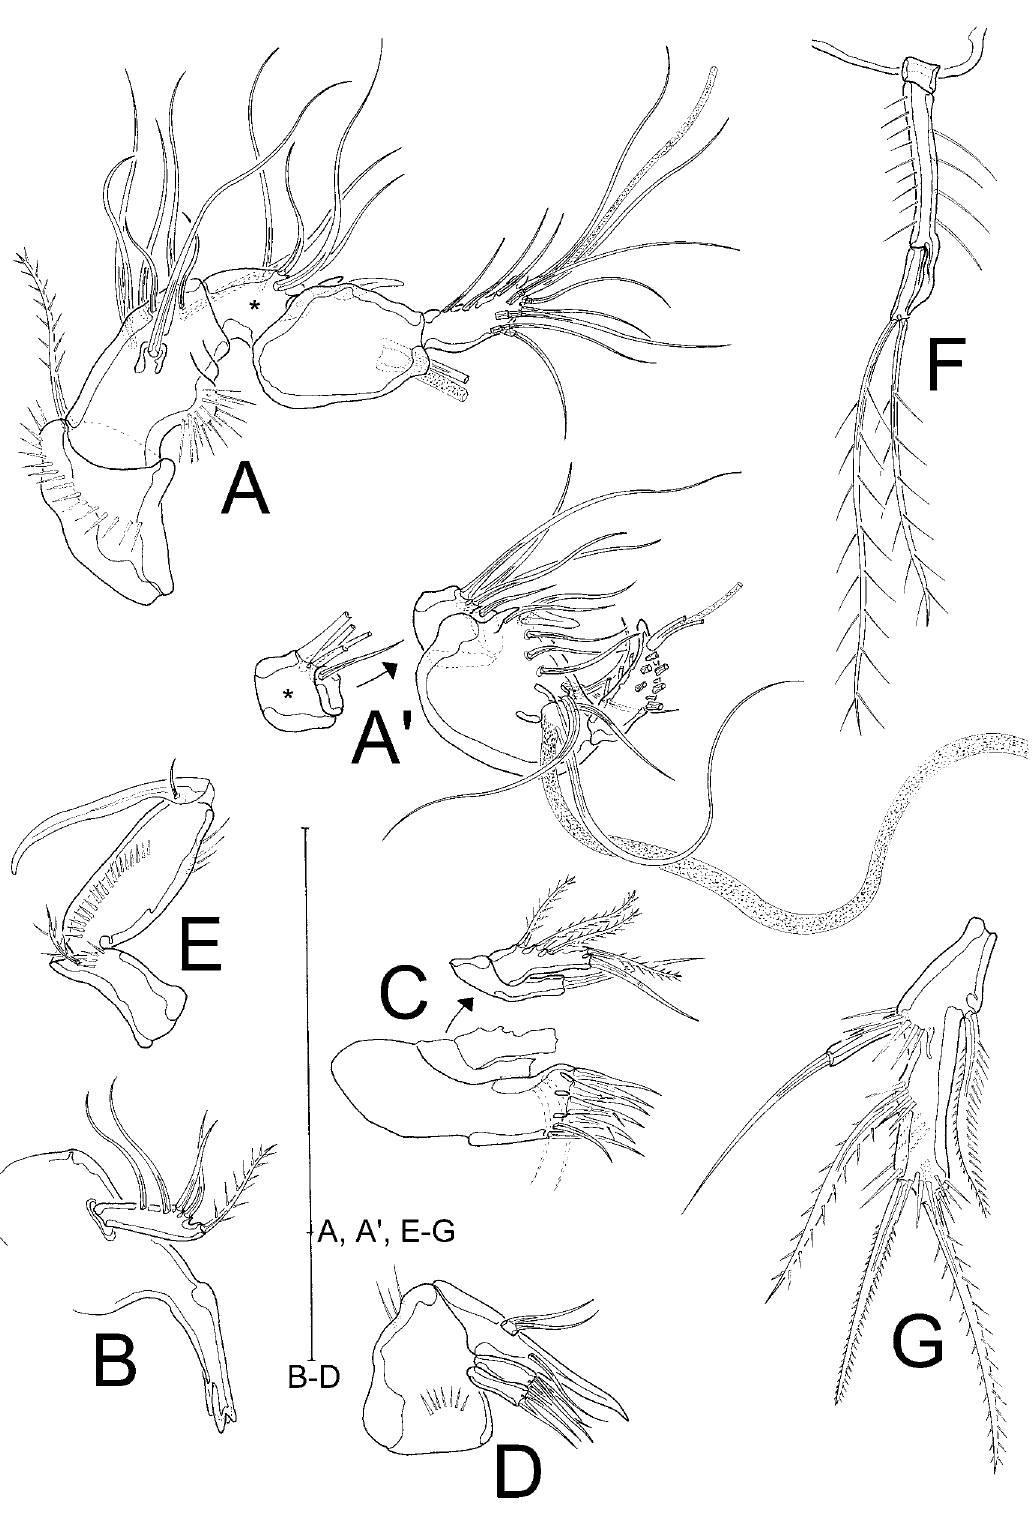
Fig. 15. Laophontodes gertraudae sp. nov., allotype, ♂ (SMF 37115/1–9). A . A1. A’ . Segments 3, 4, 5 and 6 of A1, drawn from counterpart (fourth segment marked with asterisk *). B . Md. C . Mxl. D . Mx. E . Mxp. F . P3 enp. G . P5. Scale bar = 50